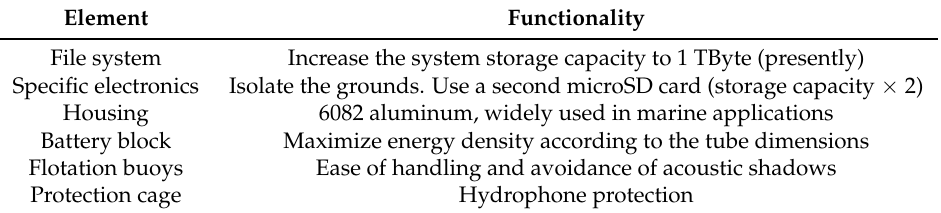
Table 2. Summary.